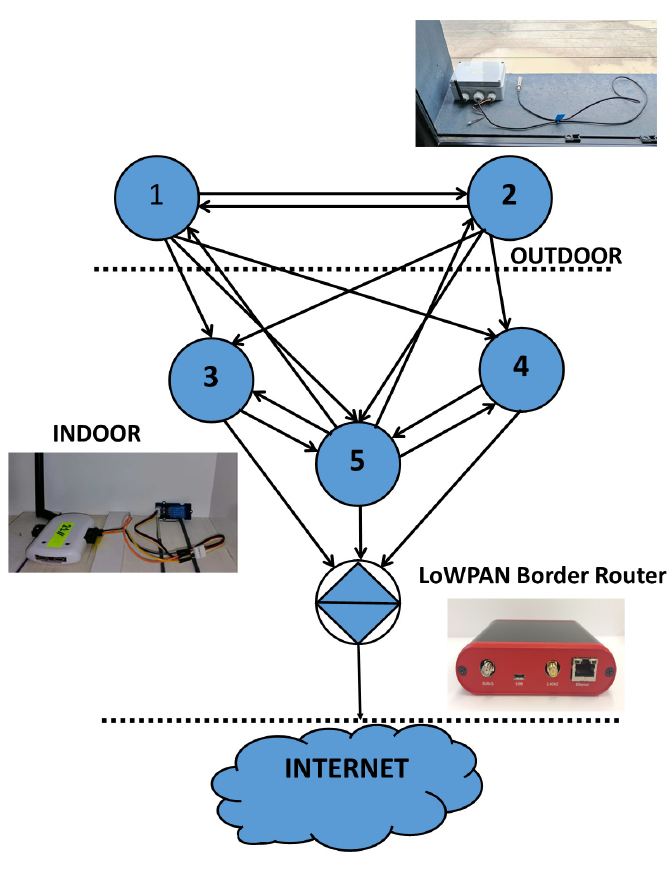
Figure 3. Network setup topology.